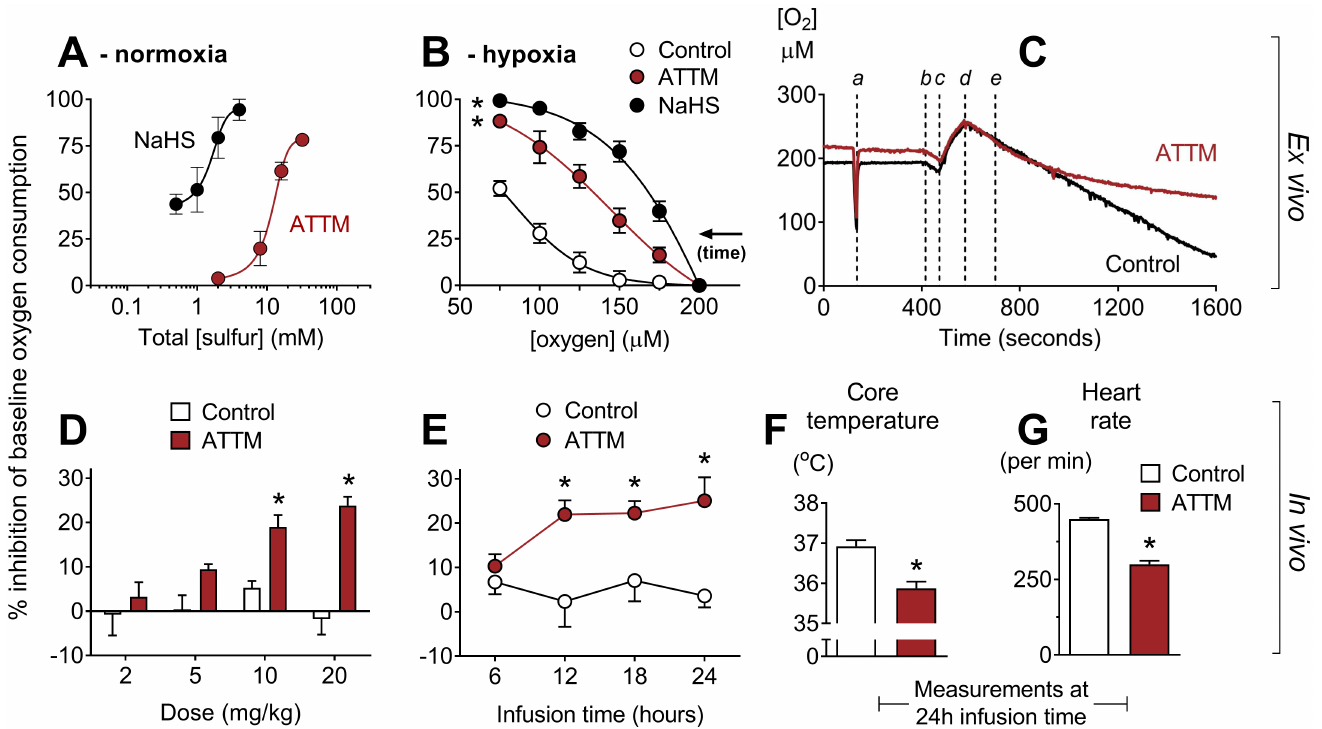
Fig 2. Inhibition of oxygen consumption by sulfide-containing drugs. (A) Ex vivo concentration response curves for ammoniumtetrathiomolybdate (ATTM) and NaHS in relative normoxia. Experiments were performed at 150–250 μ M O 2 . In (B), tissues respiredto hypoxia.Vehicle, ATTM (0.5 mM, corresponding to 2 mM total sulfur), or NaHS (0.5 mM) was addedat 200 μ M O 2 . Note that oxygen consumptionin vehicle-treated tissues also decreases at lower [O 2 ] (supplydependence) when tissues respire towards hypoxia.(C) shows a representative trace of tissues respiringto hypoxia, with the timing of the followingevents indicated: a , sensitivity test; b , addition of tissue to the chamber; c , oxygenation; d , baselinemeasurements; e , addition of ATTM or vehicle(control). (D) and (E) show the effects of ATTM in vivo followingincreasing, hourly IV bolus doses or a continuous infusion (10 mg/kg/h), respectively. (F) shows core temperatureand (G) shows echocardiography-derived heart rate at the end (24 h) of continuousinfusion. PanelsA, B, D, and E show percentageinhibitioncomparedto baselinevalues, before the additionof drugs. * p < 0.05 versus control using a two-way repeated measures ANOVA (plus Bonferroni’s test in D and E) or unpaired t -test (in F and G). n = 3–12 for ex vivo experiments, and n = 4 per group for in vivo